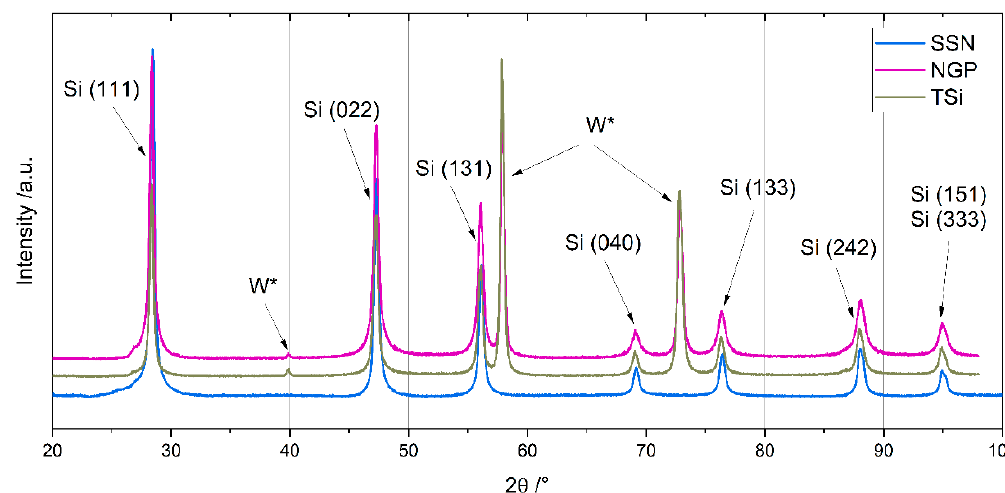
Figure A1. Reflections of the X-rays depending on the angle of incidence during XRD measurements of the Si nanoparticles; an offset was introduced for better visibility.